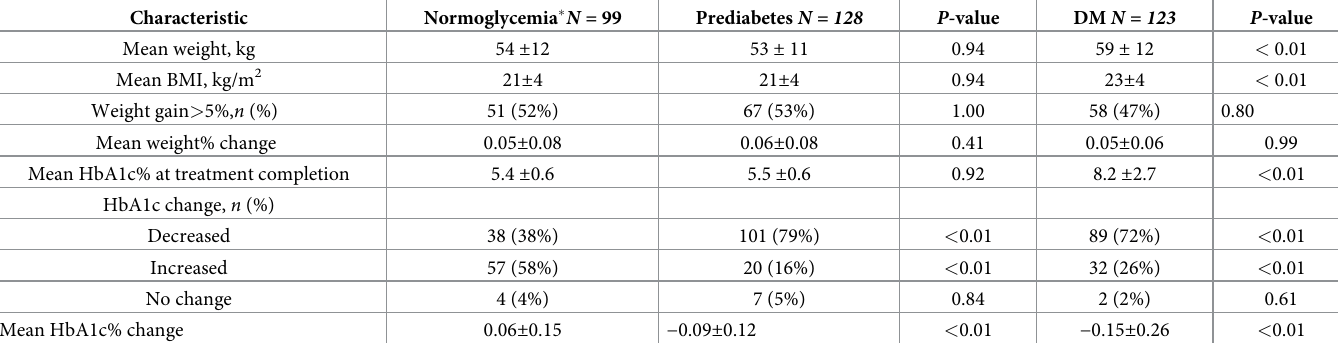
malized glycemia levels (HbA1c < 5.7%), 15 (31%) had prediabetes range hyperglycemia Table 2. Patient characteristics at tuberculosis (TB) treatment completion grouped by category at TB